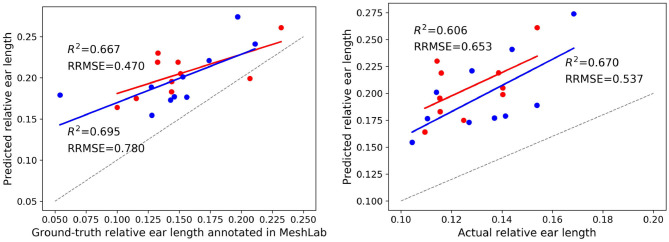
Results on the ear length of two treatments including 10 individuals grown under well water conditions (in red) and 10 individuals grown under drought conditions (in blue). (Left) Comparison between the average relative ear length identified by the Pattern-Net and the corresponding ground-truth values measured in MeshLab. (Right) Comparison between the relative ear length identified by the Pattern-Net and the corresponding physical ground-truth measurements collected post-harvest. 3D models with 2,048 points were used here.